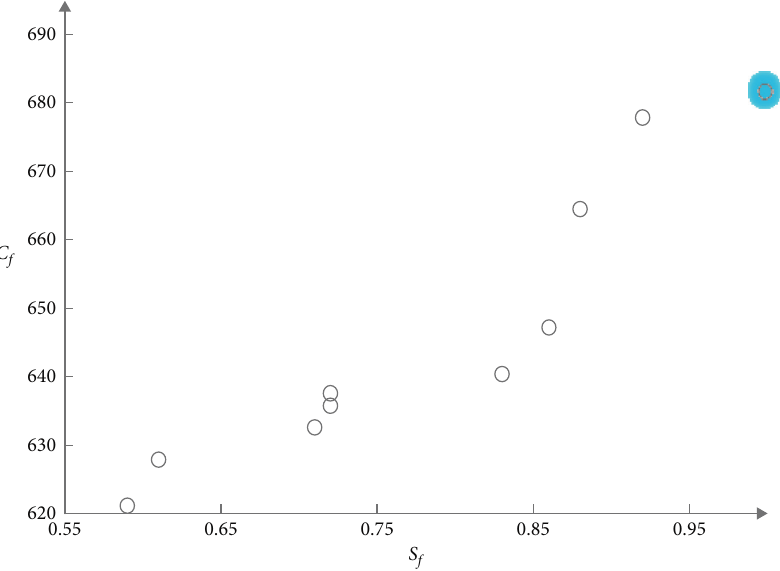
Figure 8: Noninferior solution set of example